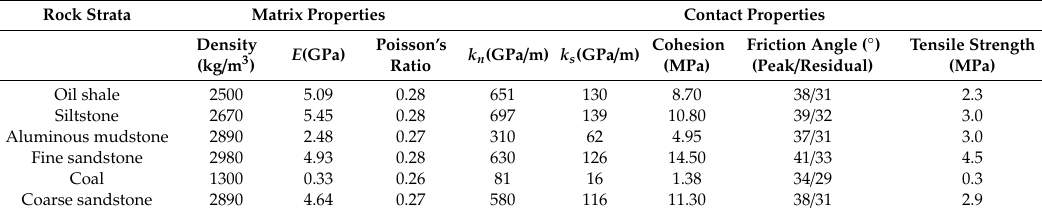
Table 3. Calibrated results of rock mass properties in the Trigon